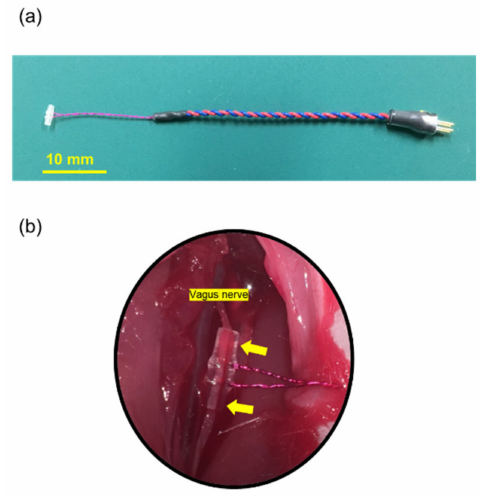
Figure 2. The cuff type electrode for vagus nerve stimulation. ( a ) The cuff type electrode used in this study. The electrode is 60 mm long, composed of 20 mm of silver wire and 40 mm of flexible lead. ( b ) The cuff type electrode surrounding the left vagus nerve. A yellow arrow shows the point to be fixed by 5–0